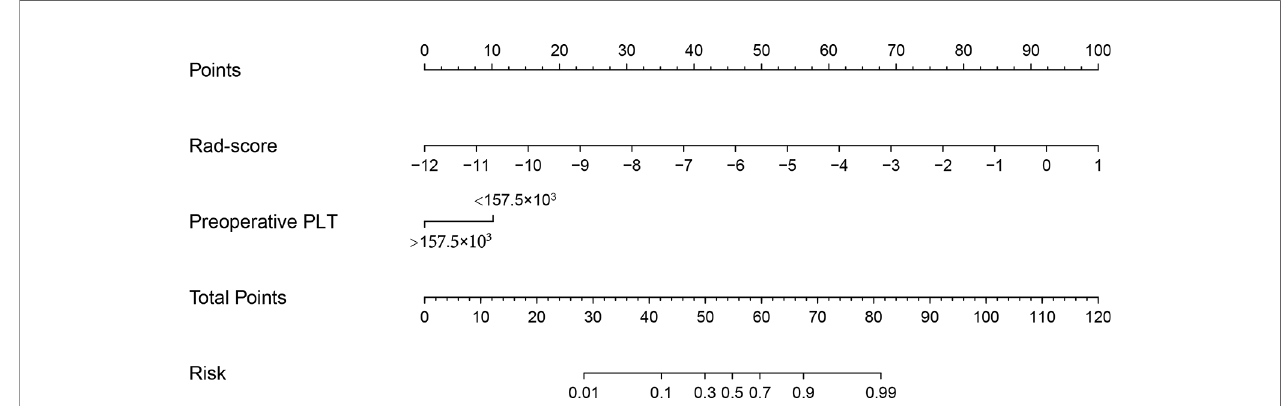
FIGURE 3 | Radiomics nomogram developed with the rad-score and the preoperative platelet count. The nomogram is valued to obtain the probability of ER by adding up the points identi fi ed on the points scale for each